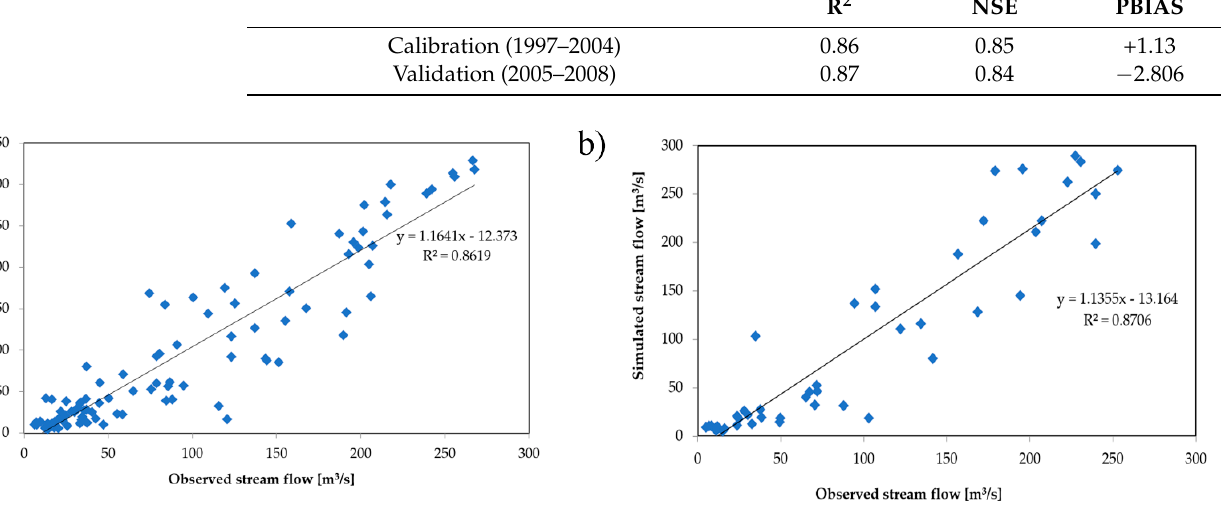
Figure 13. Scatter plot of simulated and observed flow during the ( a ) calibration (1997–2004) and ( b ) validation (2005–2008) periods.